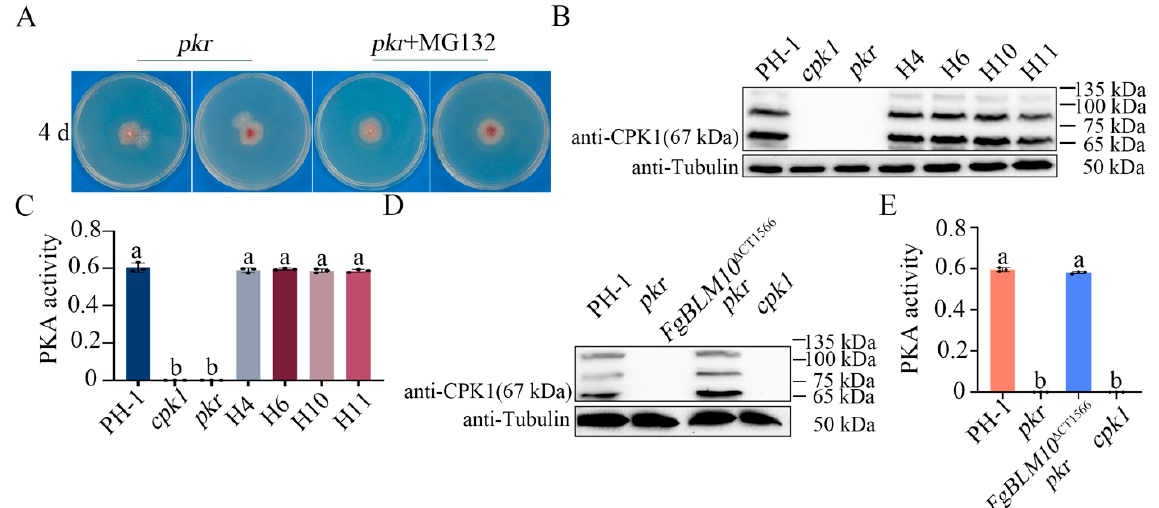
Figure 7. Assays for PKA activities and Cpk1 expression. ( A ) Four-day-old PDA cultures of the pkr mutant with or without 50µM MG132. ( B ) Western blots of total proteins isolated from the marked strains and treatment were detected with an anti-FgCpk1 antibody. The expected size of Cpk1 is 67 kDa. Detection with an anti-tubulin antibody was used as the loading control. ( C ) PKA activity was assayed with proteins isolated from hyphae of PH-1, cpk1 , pkr , H4, H6, H10, and H11. ( D ) Western blots of proteins isolated from the marked strains were detected with an anti-FgCpk1 antibody. ( E ) PKA activity was assayed with proteins from the marked strains. Different letters indicate signi fi cant differences based on ANOVA analysis followed by Duncan’s multiple range test ( p = 0.05) in a, b.